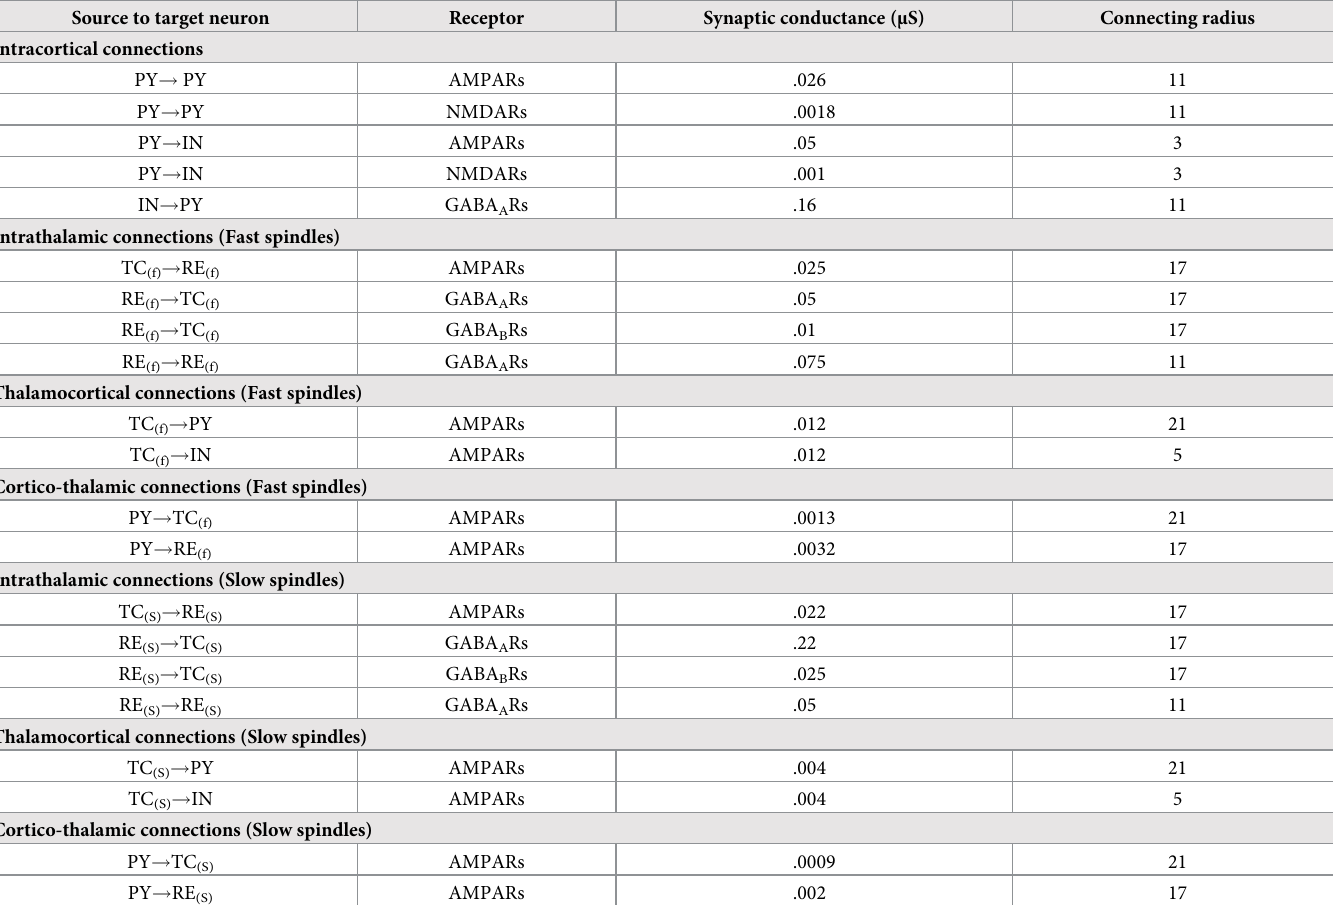
Table 3. Synaptic receptors, conductance, and their connecting radii.